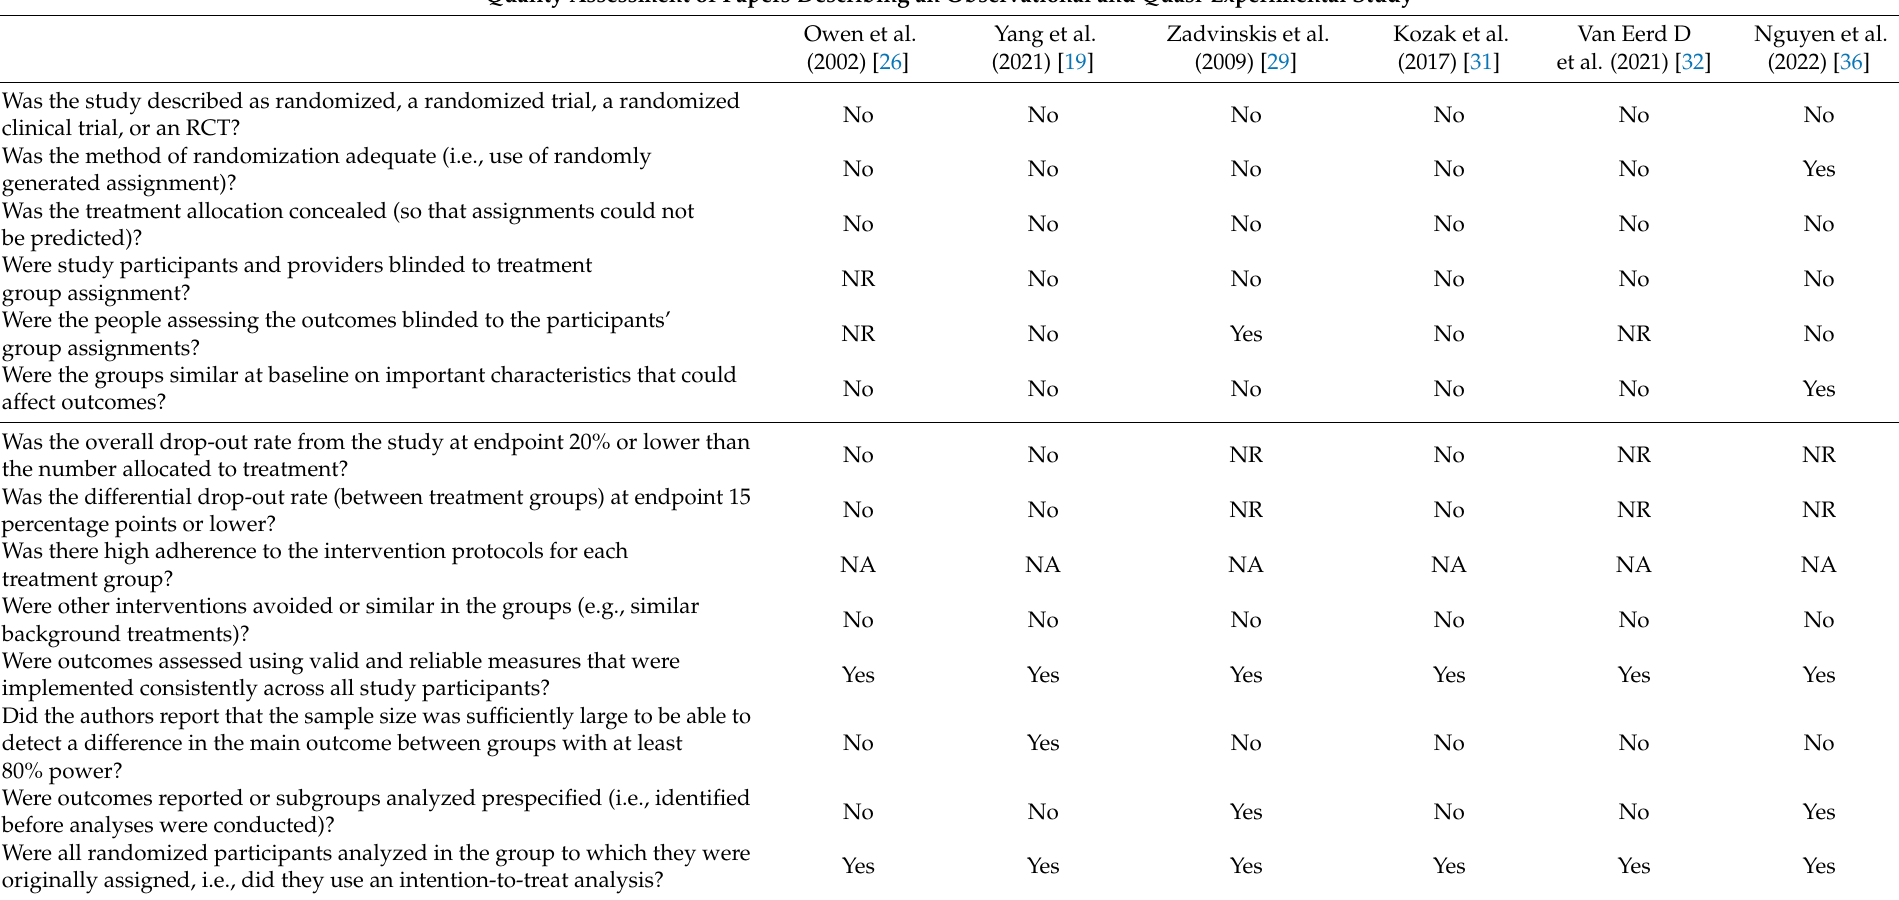
Table 5. Quality assessment of observational and quasi-experimental